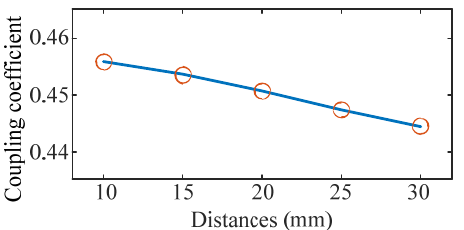
Figure 6. Coupling coefficient waveform with different distances.